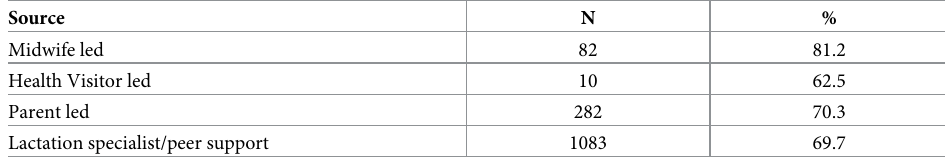
Table 2. Perceptions of positive local midwifery support for breastfeeding by group type (showing proportion of participants who strongly agree /